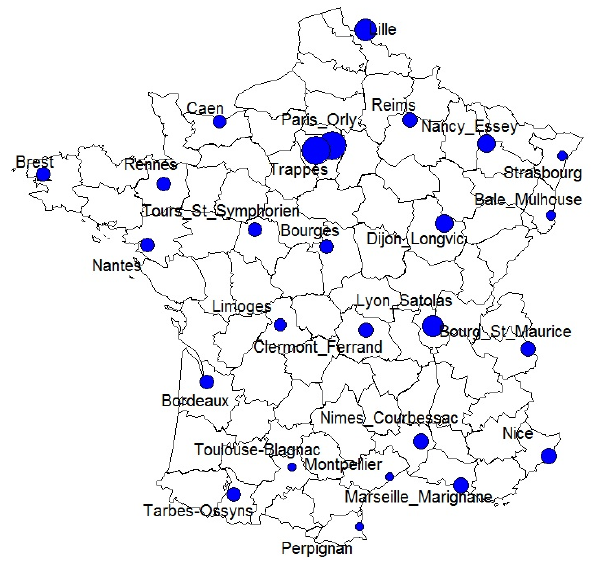
Fig. 1. Weather stations used to define global temperature for France: names, locations and circles with surfaces proportional to the weight of each station.